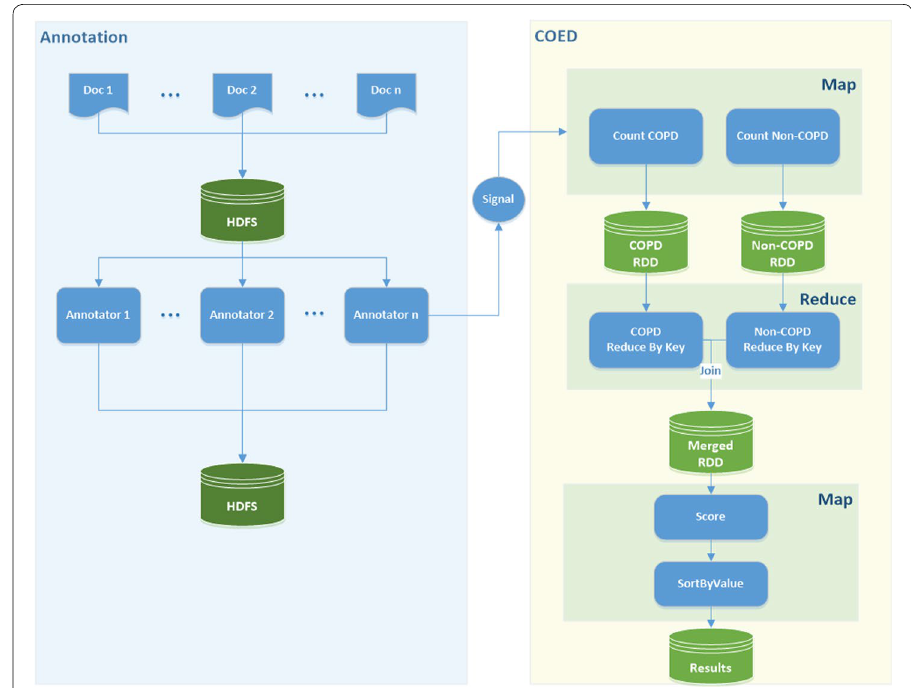
Fig. 4 Big data version of COED as implemented in the Hadoop ecosystem using Apache